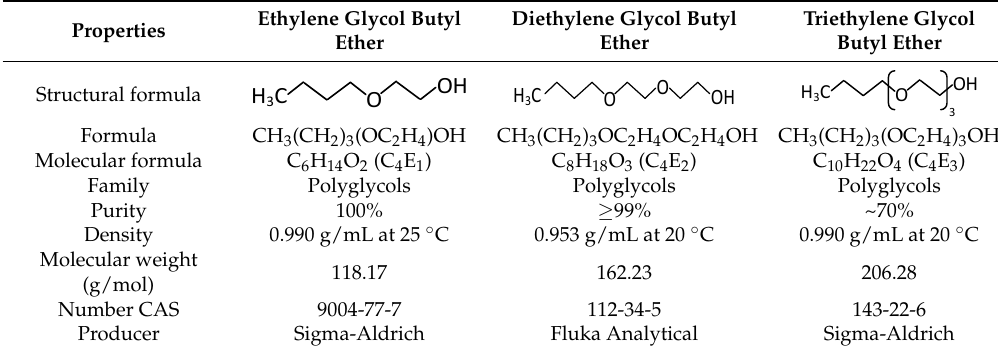
Table 2. The structures of the investigated surfactants.